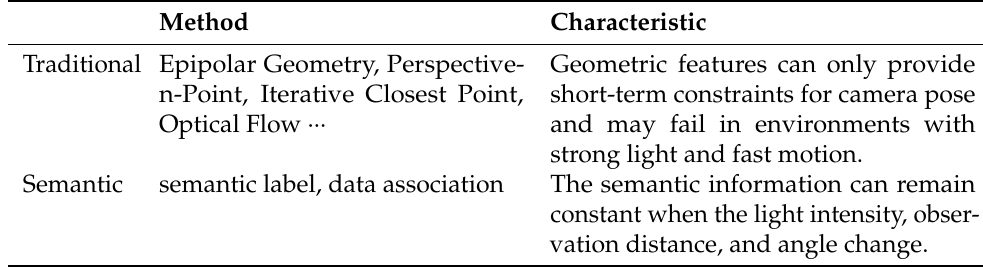
Figure 20. Zhao et al. proposed a large-scale outdoor positioning process using semantic information. Table 12. Comparison between traditional methods and semantic methods for VSLAM